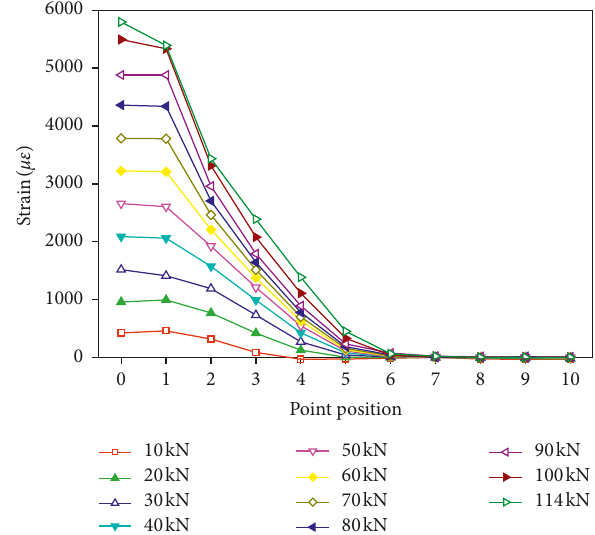
Figure 7: Single-load strain curves of GFRP bars under uncon- strained conditions.